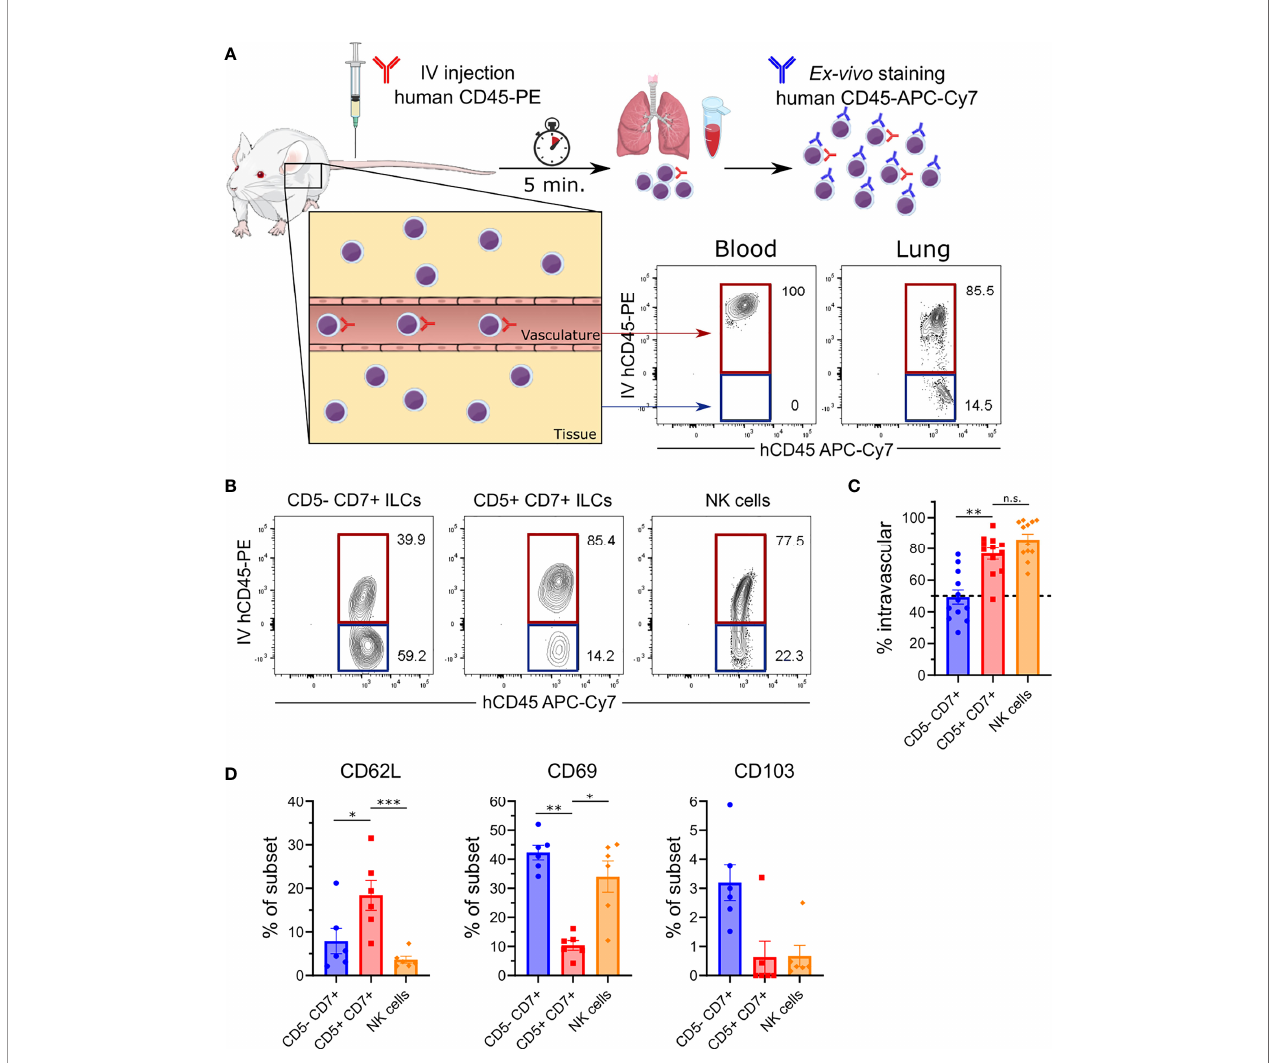
FIGURE 5 | CD5 + CD7 + ILCs mainly reside in the lung vasculature. (A) Intravascular labeling of human CD45 + hematopoietic cells in MISTRG mice engrafted with CD34 + HSPCs by intravenous (IV) injection of anti-human CD45-PE antibody. Human cells in the vasculature (highlighted in red) are stained by both the IV-injected anti-CD45 antibody (hCD45-PE) and by the ex-vivo anti-CD45 antibody (hCD45-APC-Cy7). Cells residing in the tissue (highlighted in blue) are only stained with the ex-vivo hCD45-APC-Cy7 antibody. (B) Flow cytometry analysis of intravascular (red) and extravascular (blue) CD5 - CD7 + ILCs, CD5 + CD7 + ILCs, and NK cells in the lung of HSPC-engrafted MISTRG mice. ILCs were gated as human CD45 + Lin - CD3 - TCR ab - CD94 - CD127 + cells and NK cells were gated as human CD45 + Lin - CD3 - TCR ab - CD94 + CD127 - cells as in Figure 1B . (C) Frequencies of intravascular (IV-hCD45-PE + ) human CD5 - CD7 + ILCs, CD5 - CD7 + ILCs, and NK cells in the lung (n = 12) as determined in (B) . (D) Frequency of CD62L, CD69, and CD103 expression by human lung CD5 - CD7 + ILCs, CD5 - CD7 + ILCs, and NK cells from HSPC- engrafted MISTRG mice (n = 6). n.s., not signi fi cant; * P < 0.05, ** P < 0.01, *** P < 0.001 by one-way ANOVA, Tukey ’ s post-test. Data represent mean ± SEM and are representative of at least two independent experiments. (A) was adapted from Mind the